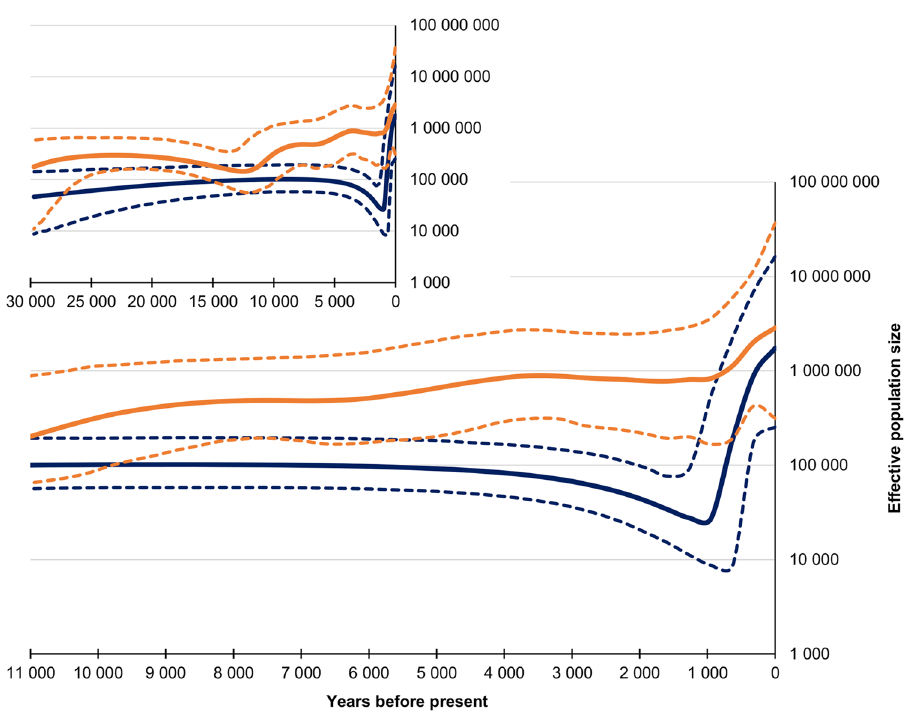
Figure 2. Effective population size ( N e ) comparison for Finn-characteristic (dark blue, N = 281) and non- Finn-characteristic (orange, N = 562) sequences. The larger graph zooms in on the last 11,000 years. In both graphs on the X-axis is time as years before present and on the Y-axis is effective population size represented on a logarithmic scale. The continuous center lines represent the mean for the N e , and the dotted lines are the 95% highest posterior density